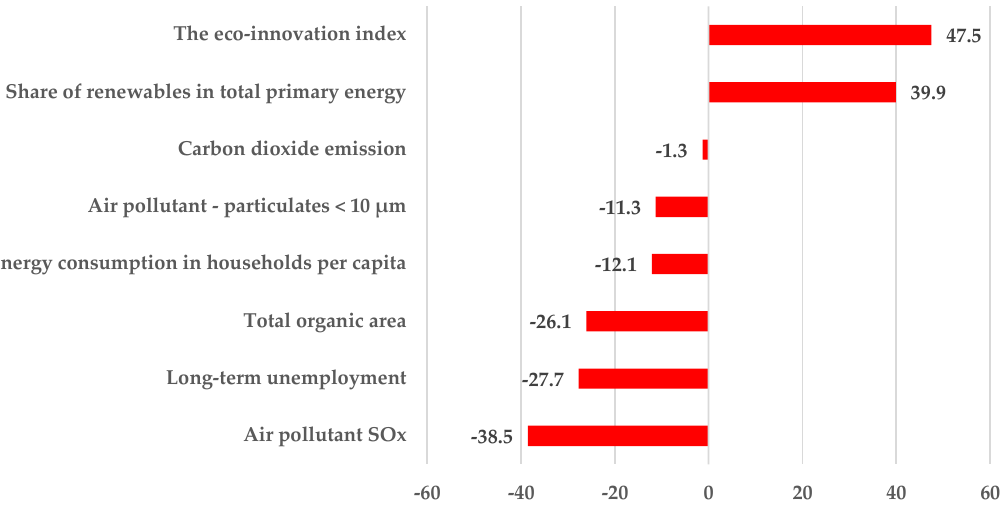
Figure 6. Net change (%) in SDG indicators, EU-28, 2010–2018. Own study, based on [31].